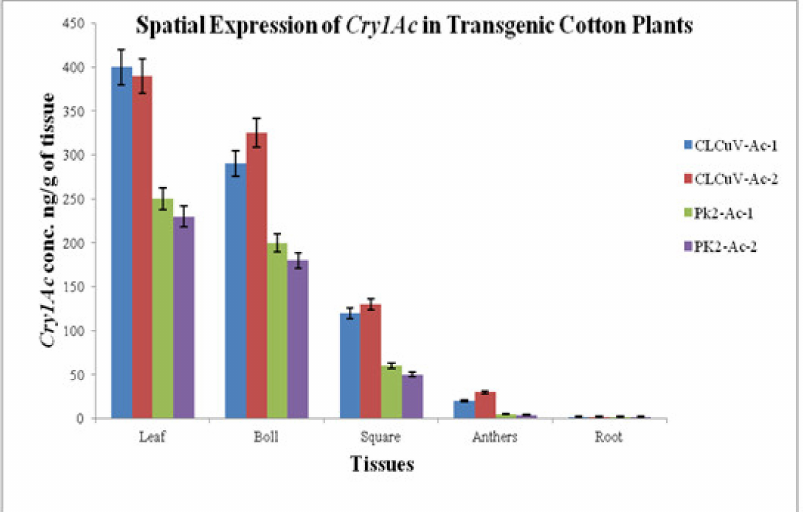
Figure 5. Spatial expression of Cry1Ac in the anthers, bolls, leaves, squares and roots of transgenic cotton